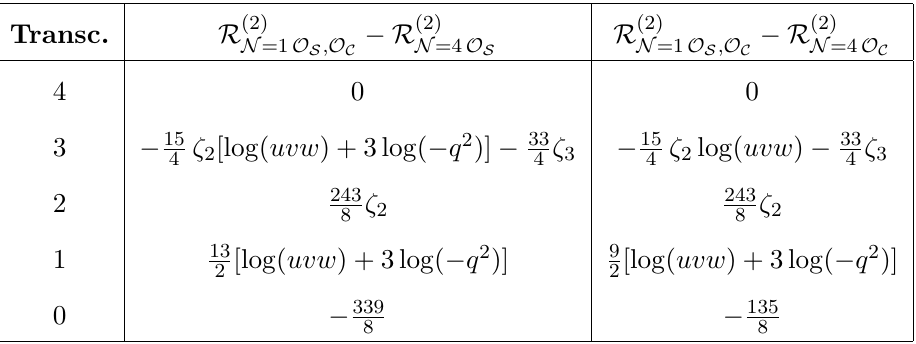
Table 5 . Di(cid:11)erence between two-loop Catani remainders of operators O S and O C when calculated in N =4 and N =1 SYM, split by transcendentality